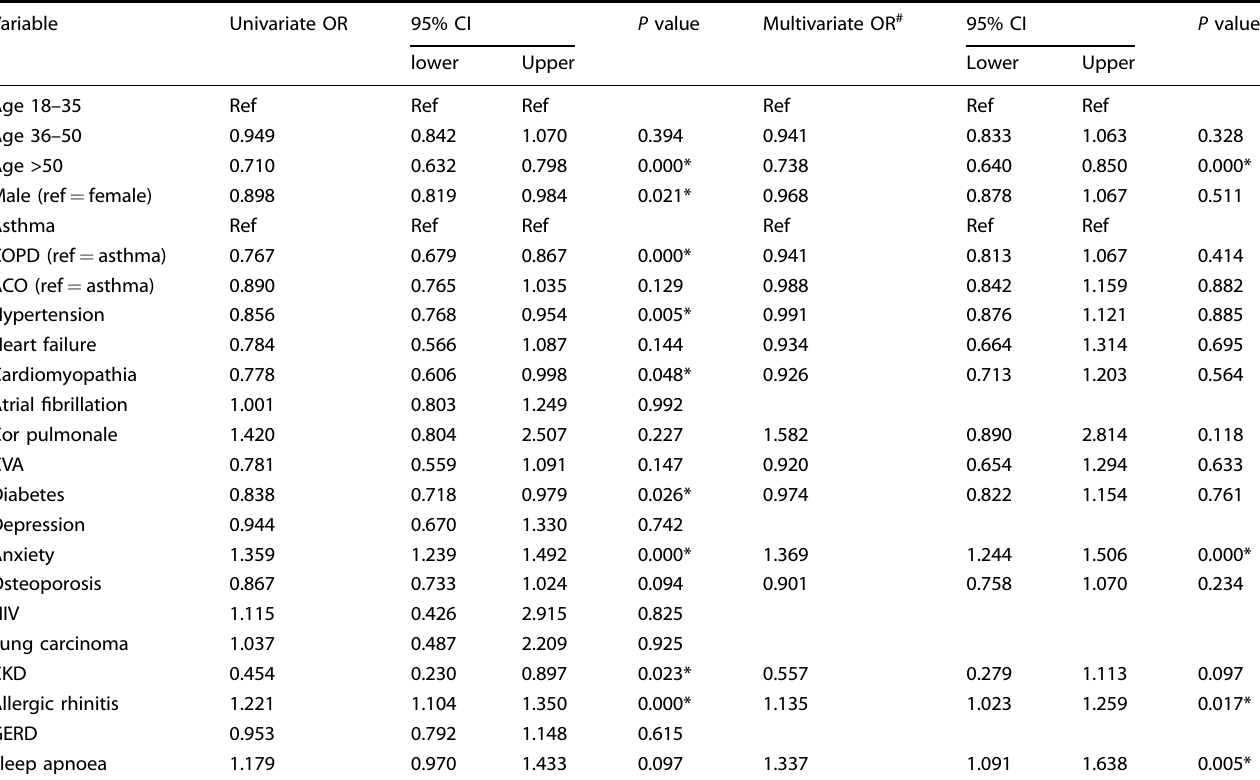
Table 3. Associations with work